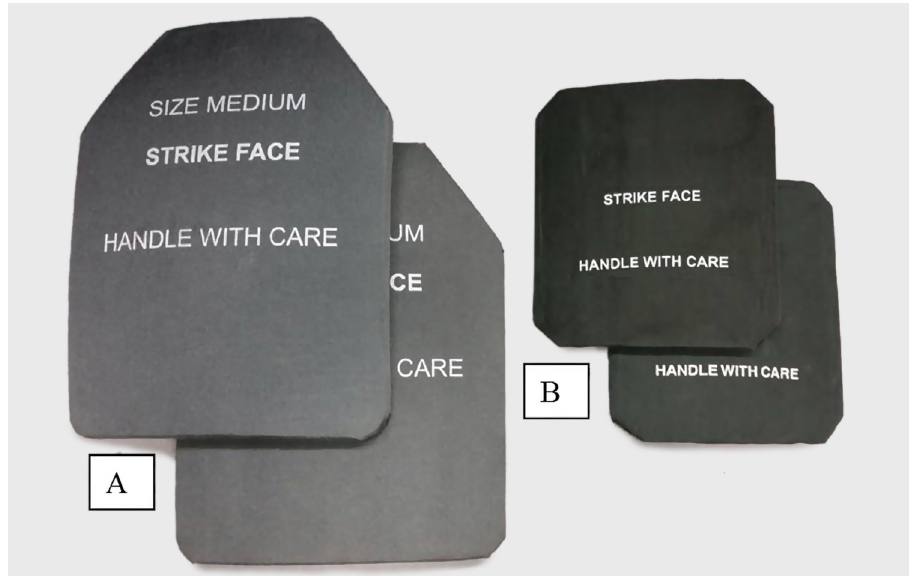
Fig 3. Ballistic plate inserts used in configurations BA-3 through BA-7. Foot note: A is front and back plates; B is side plates.